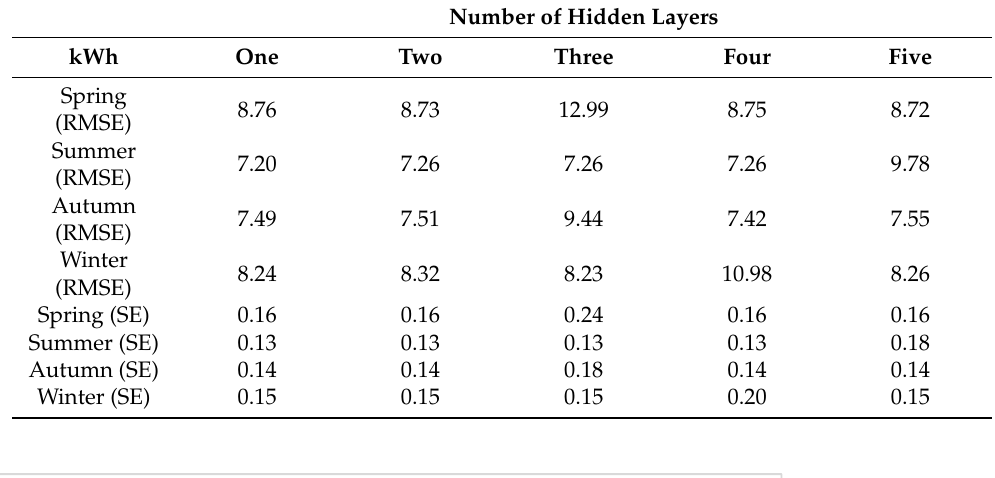
0.0010.0020.0030.0040.0050.00